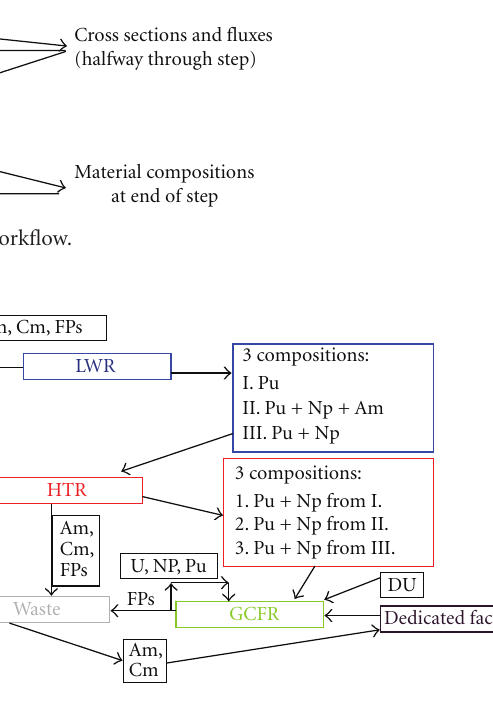
Figure 3: Sketch of the proposed